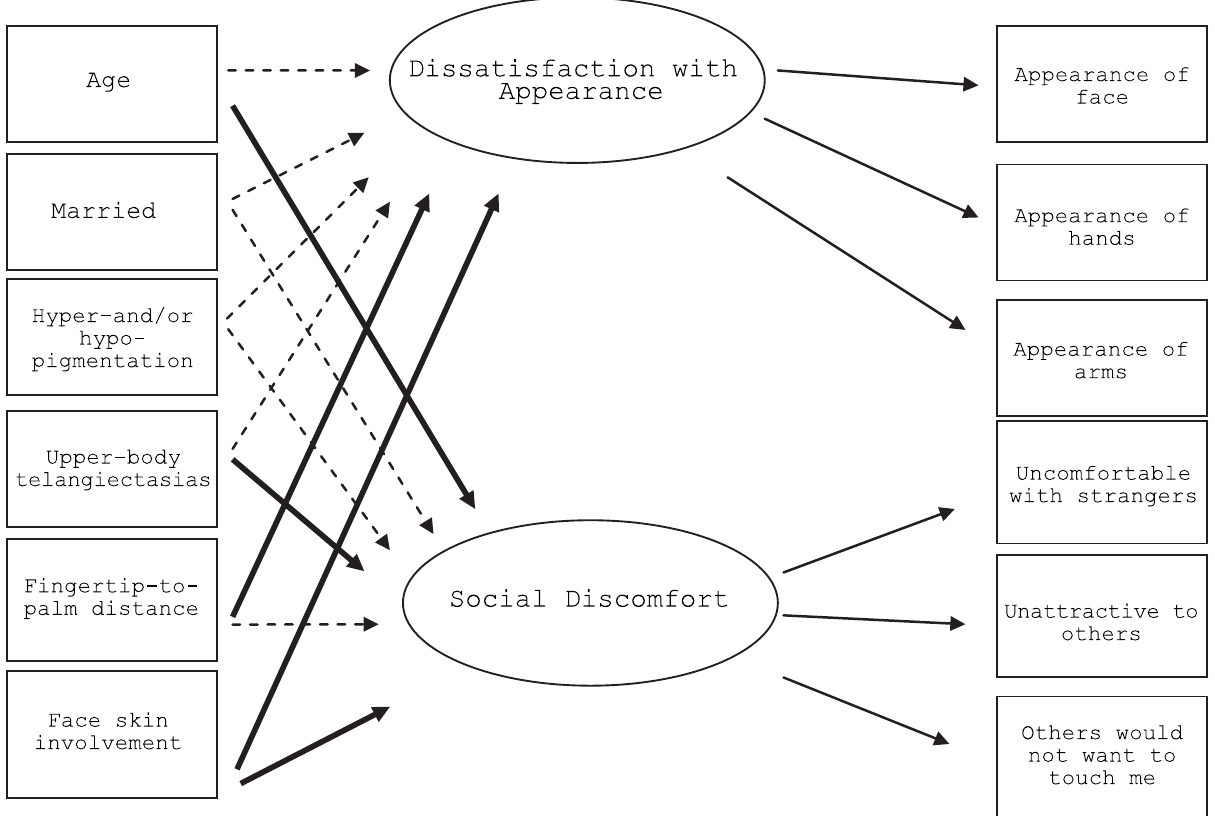
Figure 1. Structural equation model of relationships with sociodemographic and disease variables.